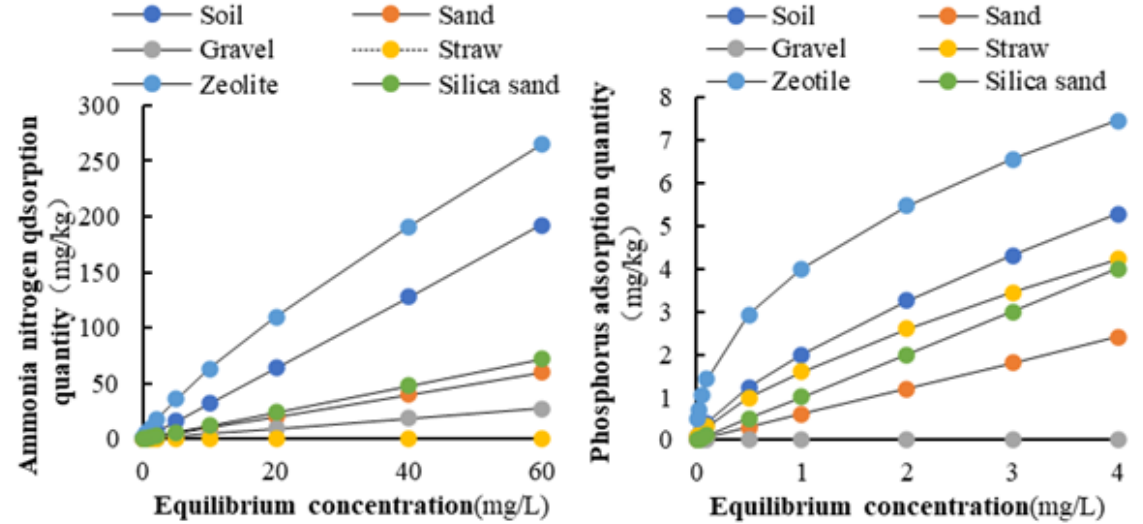
Figure 6. Freundlich adsorption curves of NH 4+ -N and TP.